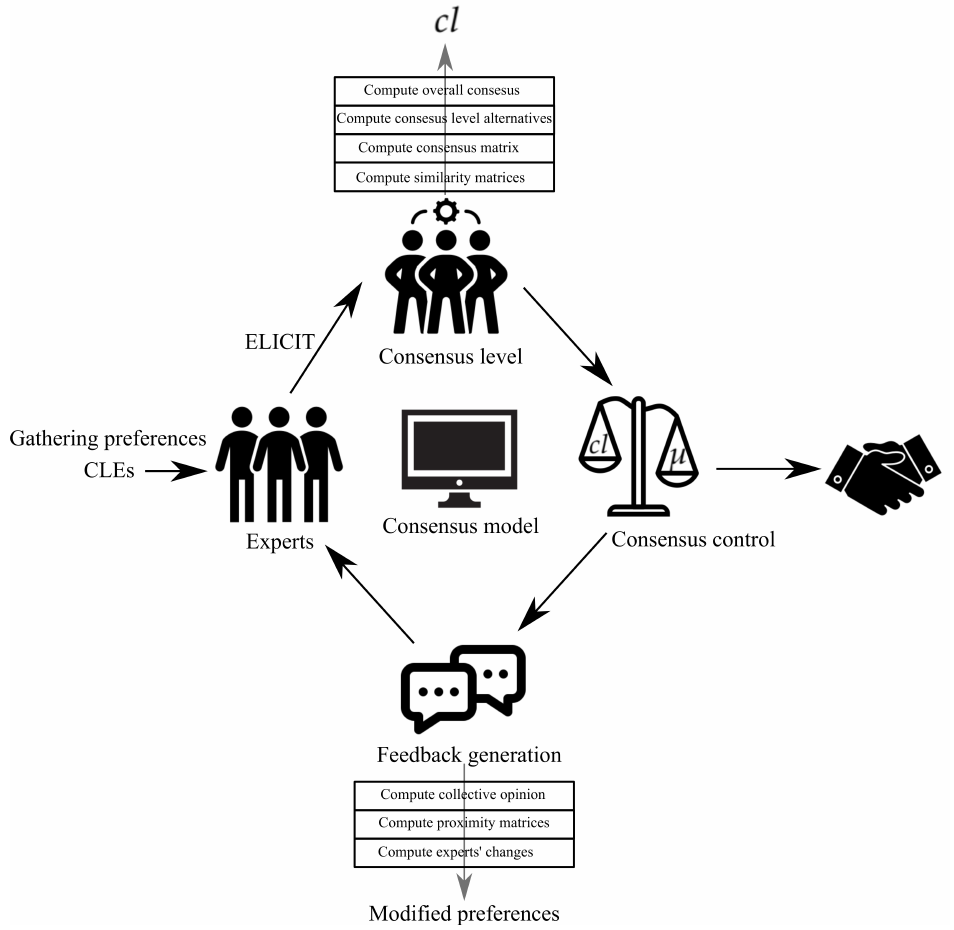
Figure 5. Consensus model resolution